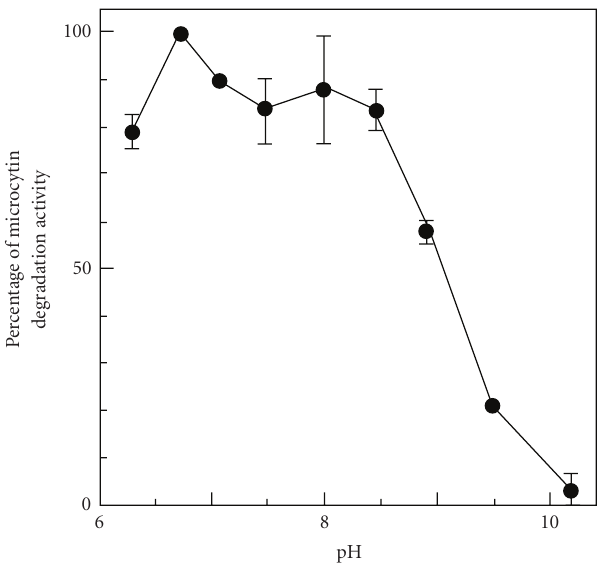
Figure 3: E ff ect of pH on microcystin-LR degradation activity of Sphingopyxis sp. strain C-1. MC degradation activity was determined as the MCLR concentration at 0 hour and 3 hours. The error bars indicate standard deviation ( n = 3).